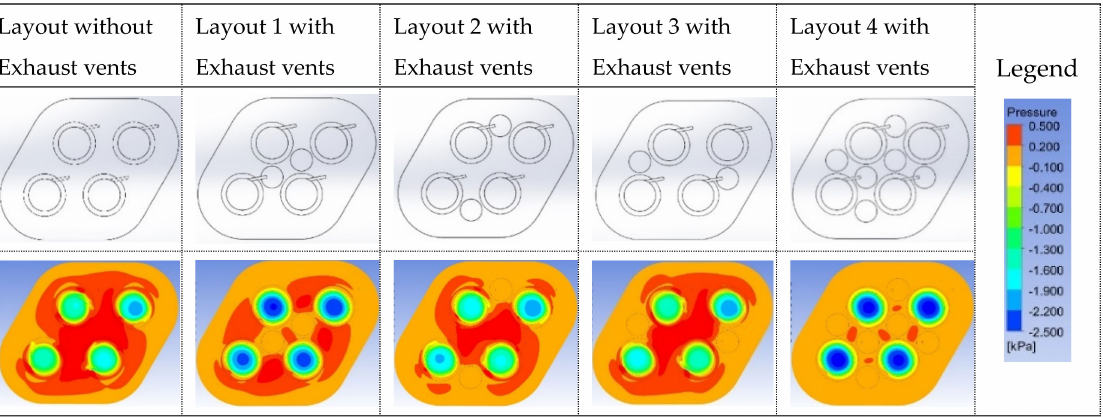
Figure 17. Pressure distribution of quad-vortex grippers with exhaust vents (configuration 5, L = 4/3 D 3